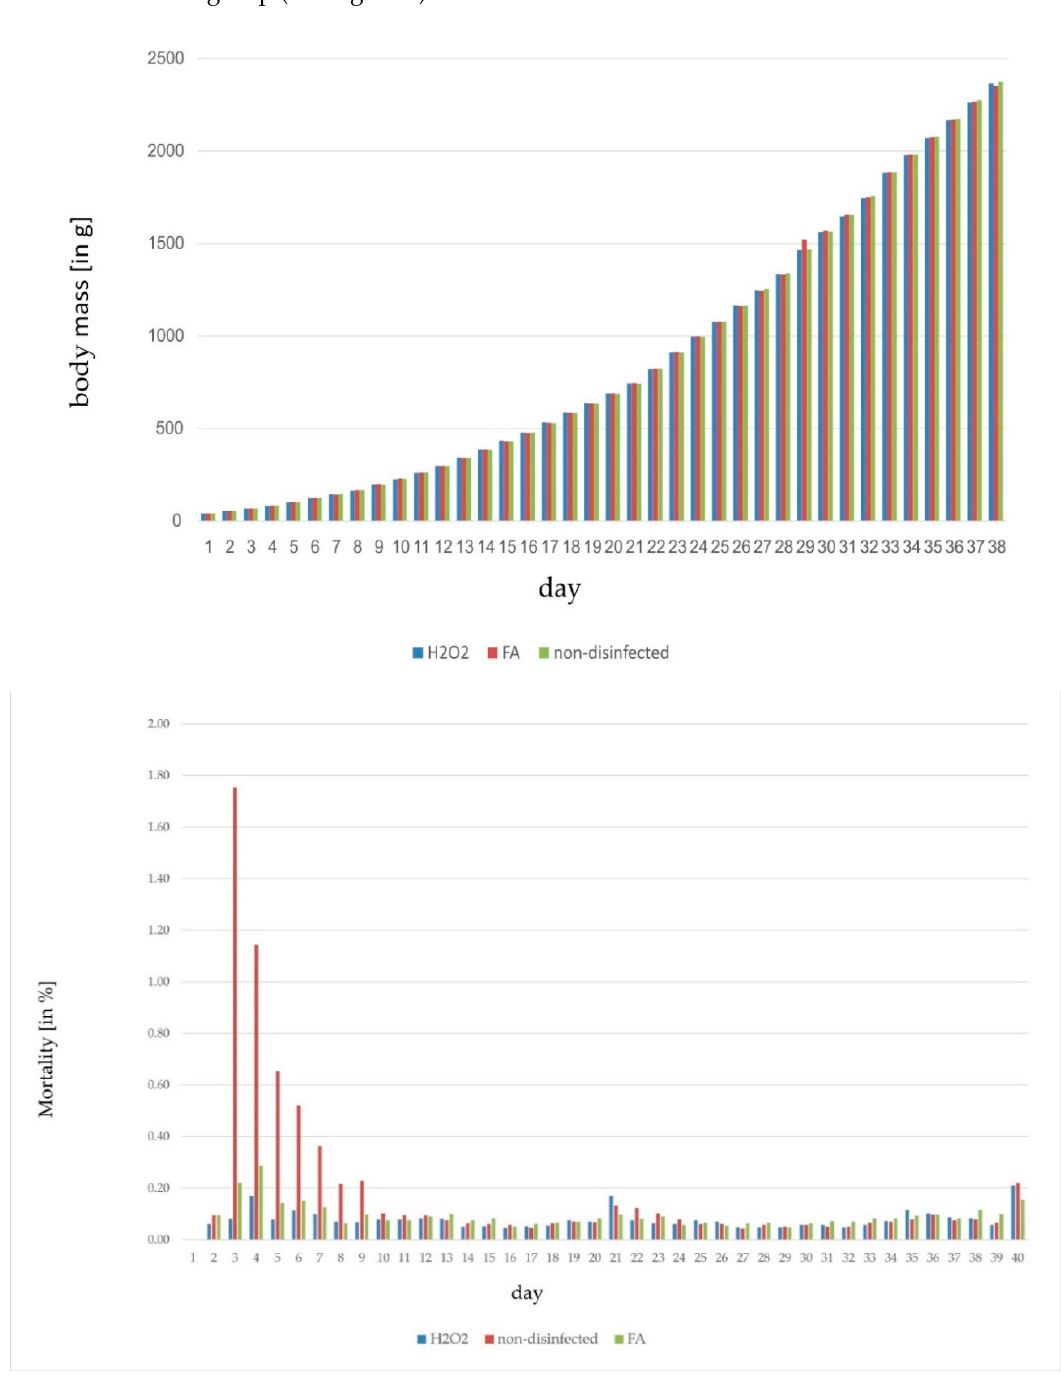
Figure 1. Body mass performance and daily mortality in trials 1 and 2.